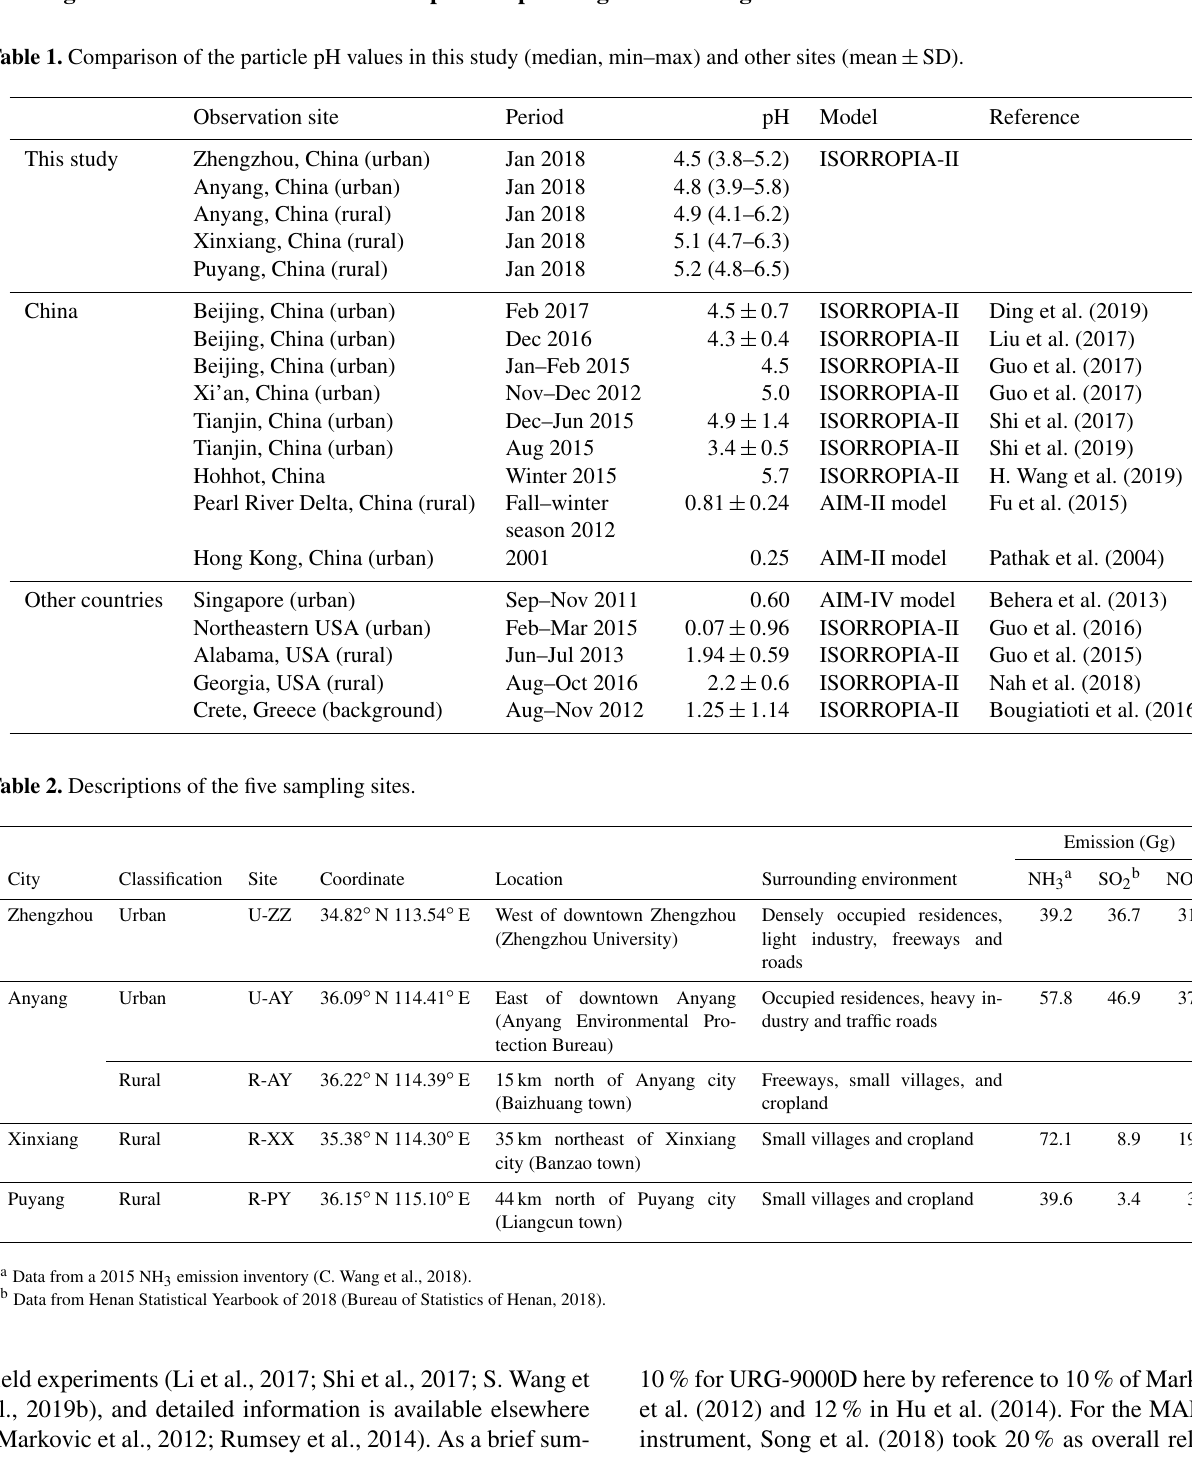
Table 1. Comparison of the particle pH values in this study (median, min–max) and other sites (mean ± SD). Observation site Period pH Model